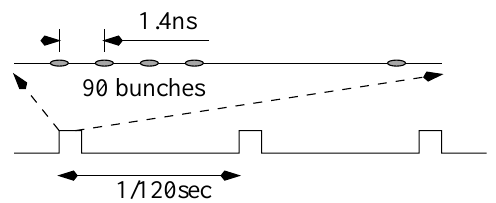
FIG. 8. Bunch structure in the modern